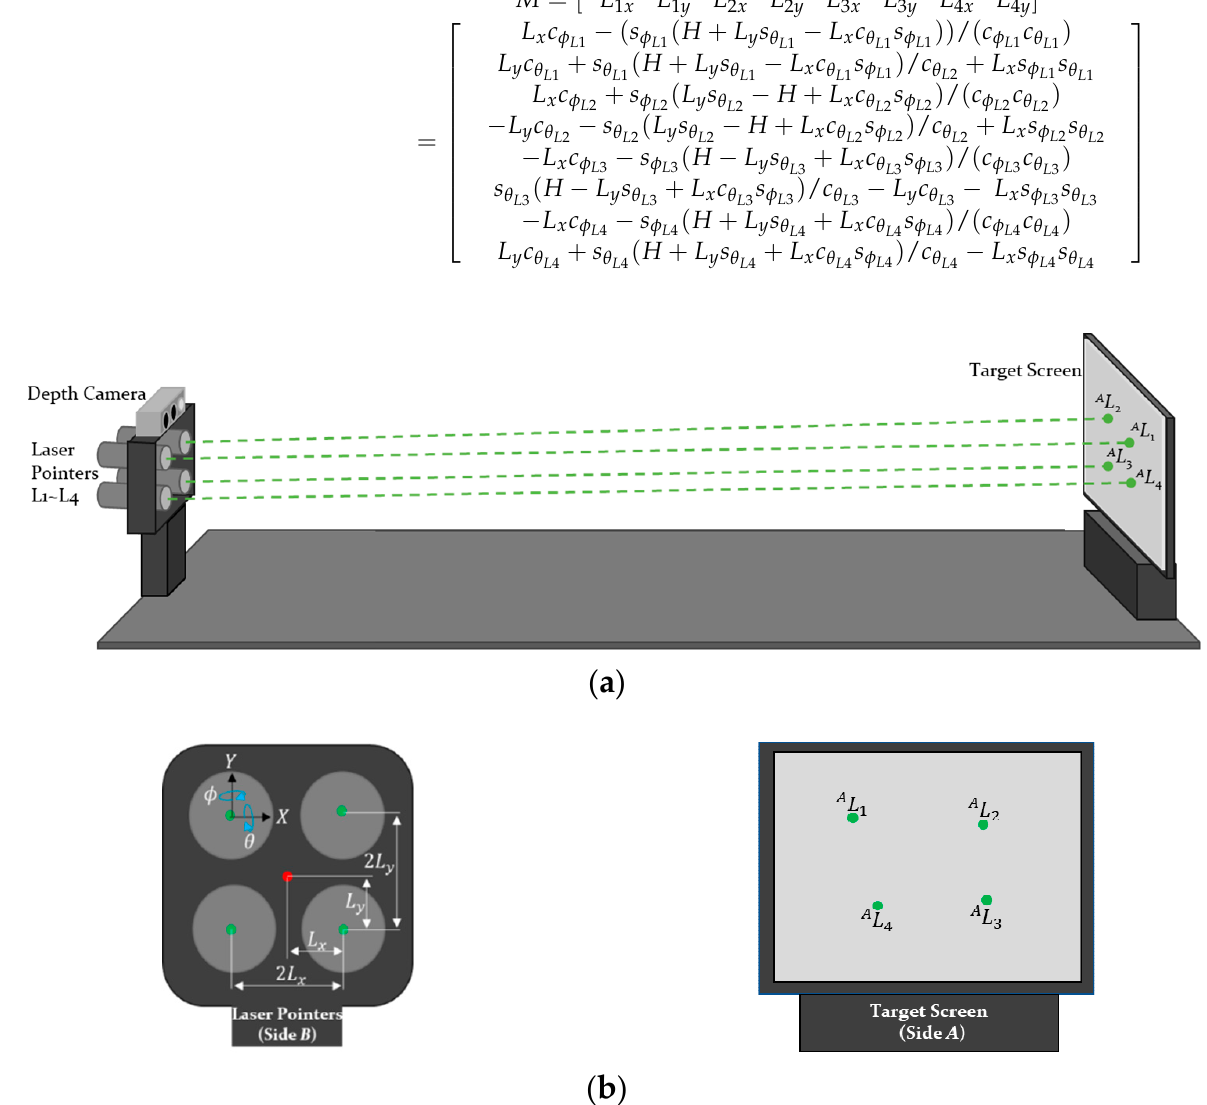
Figure 1. Design of the jig for laser calibration: ( a ) overall design of the jig module; and ( b ) magnified plot of each side in the jig module.